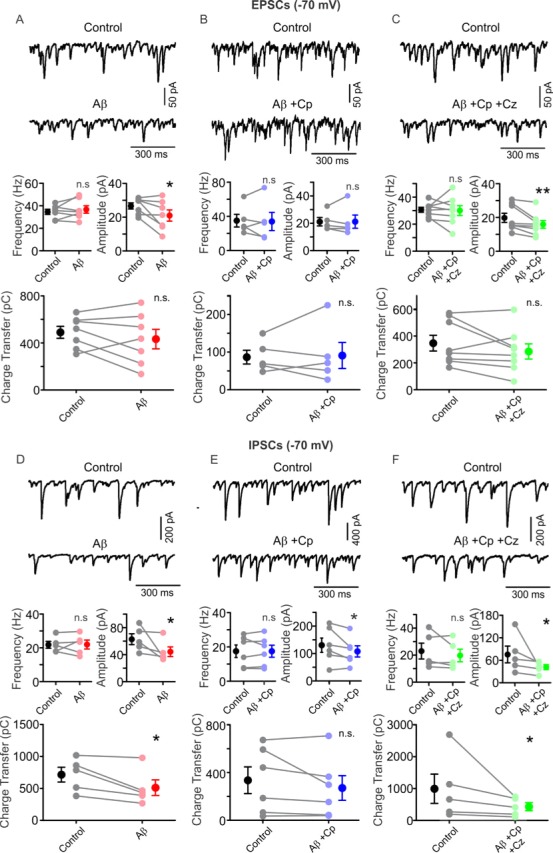
TrpV1 activation prevents Aβ-induced impairment of EPSC/IPSC current balance.(A) Representative traces (top) of EPSCs (PC, Vh=-70mV) before (control, black) and after 1 µM Aβ application (red) in hippocampal slices activated with 100 nM KA. Summary-graph (bottom) of the EPSCs frequency, amplitude and charge transfer before (control, black) and after Aβ application (red). (B) Representative traces (top) of EPSCs (PC, Vh=-70mV) before (control, black) and after 1 µM Aβ plus 5 µM Cp application (blue) in hippocampal slices activated with 100 nM KA. Summary-graph (bottom) of the EPSC frequency, amplitude and charge transfer before (control, black) and after Aβ+Cp application (blue). (C) Representative traces (top) of EPSCs (PC, Vh=-70mV) before (control, black) and after 10 µM Cz together with 1 µM Aβ plus 5 µM Cp application (green) in hippocampal slices activated with 100 nM KA. Summary-graph (bottom) of the EPSC frequency, amplitude and charge transfer before (control, black) and after Aβ+Cp+ Cz application (green). (D) Representative traces (top) of IPSCs (PC, Vh=-70mV) before (control, black) and after 1 µM Aβ application (red) in hippocampal slices activated with 100 nM KA. Summary-graph (bottom) of the IPSC frequency, amplitude and charge transfer before (control, black) and after Aβ application (red). (E) Representative traces (top) of IPSCs (PC, Vh=-70mV) before (control, black) and after 1 µM Aβ plus 5 µM Cp application (blue) in hippocampal slices activated with 100 nM KA. Summary-graph (bottom) of the IPSC frequency, amplitude and charge transfer before (control, black) and after Aβ+Cp application (blue). (F) Representative traces (top) of IPSCs (PC, Vh=-70mV) before (control, black) and after 10 µM Cz together with 1 µM Aβ plus 5 µM Cp application (green) in hippocampal slices activated with 100 nM KA. Summary-graph (bottom) of the IPSC frequency, amplitude and charge transfer before (control, black) and after Aβ+Cp+ Cz application (green). Note that Cp treatment reversed Aβ-related impairment of excitatory/inhibitory current balance by restoring EPSC amplitude and IPSC charge transfer. Quantifications were performed by averaging 5 min of control and the last 5 min of treatment with values taken over 1 min period (for experimental data see Figure 5—source data 1). Wilcoxon matched-pairs test (one-tailed) was used for statistical significance on absolute values. Each experiment is presented as before-after data and the mean ±SEM is shown. * indicates p < 0.05, **p < 0.01 and n.s. indicates no statistically significant differences.
10.7554/eLife.37703.017Figure 5—source data 1.Experimental data for Figure 5.